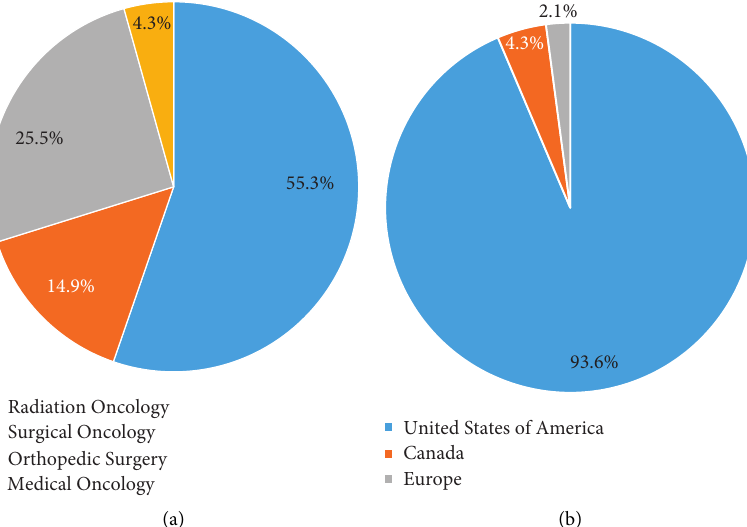
Figure 1: Demographics of surveyed providers. Breakdown of oncologic specialty (a) and practice location (b) among 47 survey respondents.